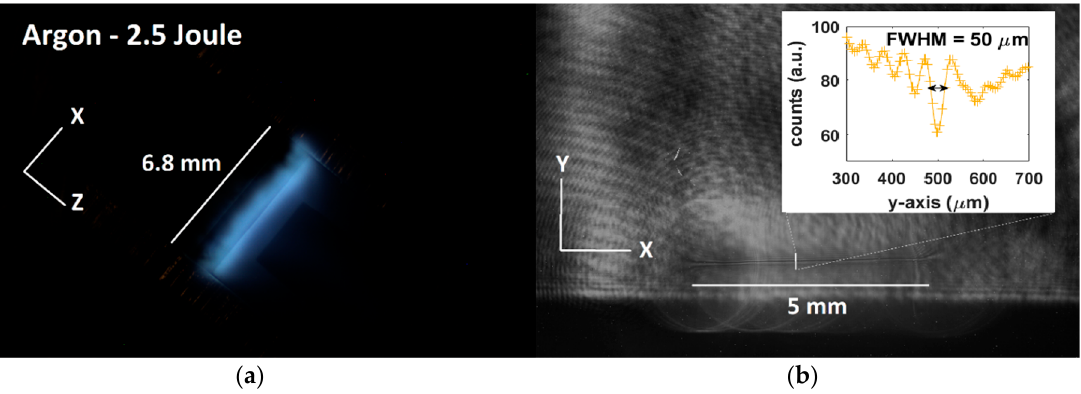
Figure 6. Experimental measurement of plasma formation in Ar gas target at 51.2 bar backing pressure and 2.5-J laser energy. (a) Top-view image of the optical plasma emission (the gas nozzle is visible in the background); (b) shadowgraphy image of the elongated plasma structure and inner diameter measurement on the x-y plane.